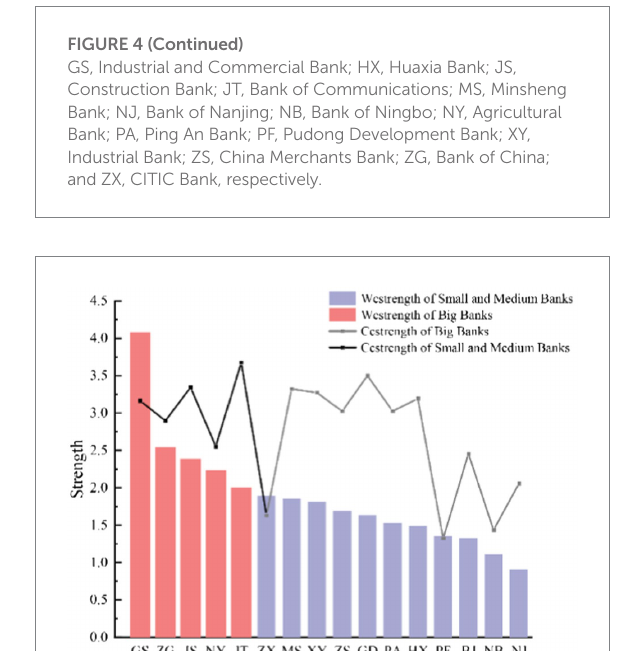
FIGURE 5 Nodes’ strength of banking networks.